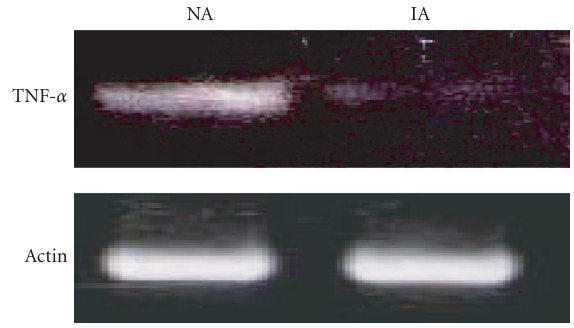
Figure 2. E ff ect of T cruzi infection on TNF- α gene expression in astrocytes. RT-PCR analysis was performed as described in [24]. Briefly, one microgram of total RNA from either infected (IA) or noninfected astrocytes (NA) was reverse-transcribed to cDNA. The cDNA sample was used as a template for 25–35 cy- cles of PCR using primers for rat TNF- α and actin as a control housekeeping gene to check the homogeneity of di ff erent sam- ples. Due to the fact that RNA from infected cells contained an additional source of RNA originating from T cruzi , the prepara- tions were adjusted so that the levels of actin transcripts would be comparable in IA and NA